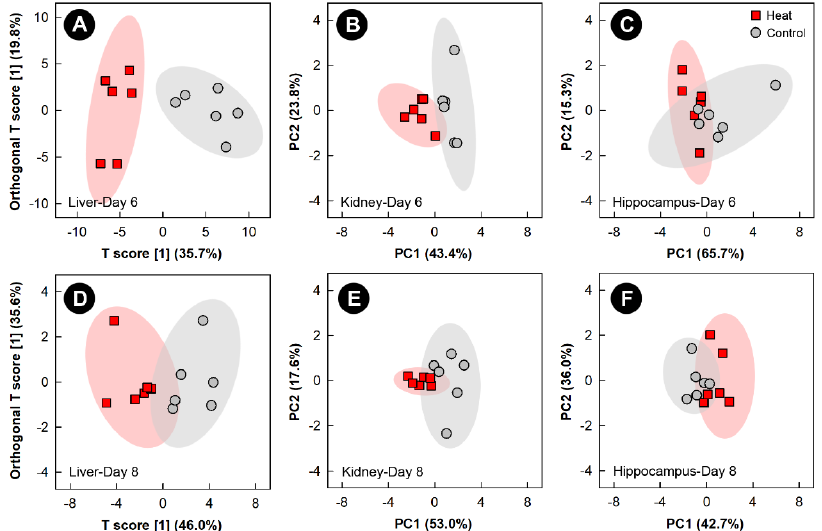
Figure 4. Orthogonal Partial Least Squares Discriminant Analysis (OPLS-DA) score plots of the liver metabolome of chicks exposed to heat stress relative to control chicks, created using the spectral bins which were determined to be altered ( p ≤ 0.050) by Variable Importance Analysis, based on random Variable Combination (VIAVC) analysis, and/or the univariate Mann – Whitney U test. ( A ) Liver at day 6; ( D ) liver at day 8. The x- and y -axis in the OPLS-DA plots represent the predictive (between-group separation) and orthogonal (within group-variation) components of the data, re- spectively. Principal component analysis (PCA) score plots of the kidney and hippocampus metab- olome of chicks exposed to heat stress relative to control chicks. ( B ) Kidney at day 6; ( C ) hippocam- pus at day 6; ( E ) kidney at day 8; and ( F ) hippocampus at day 8. The x - and y -axis of PCA plots show